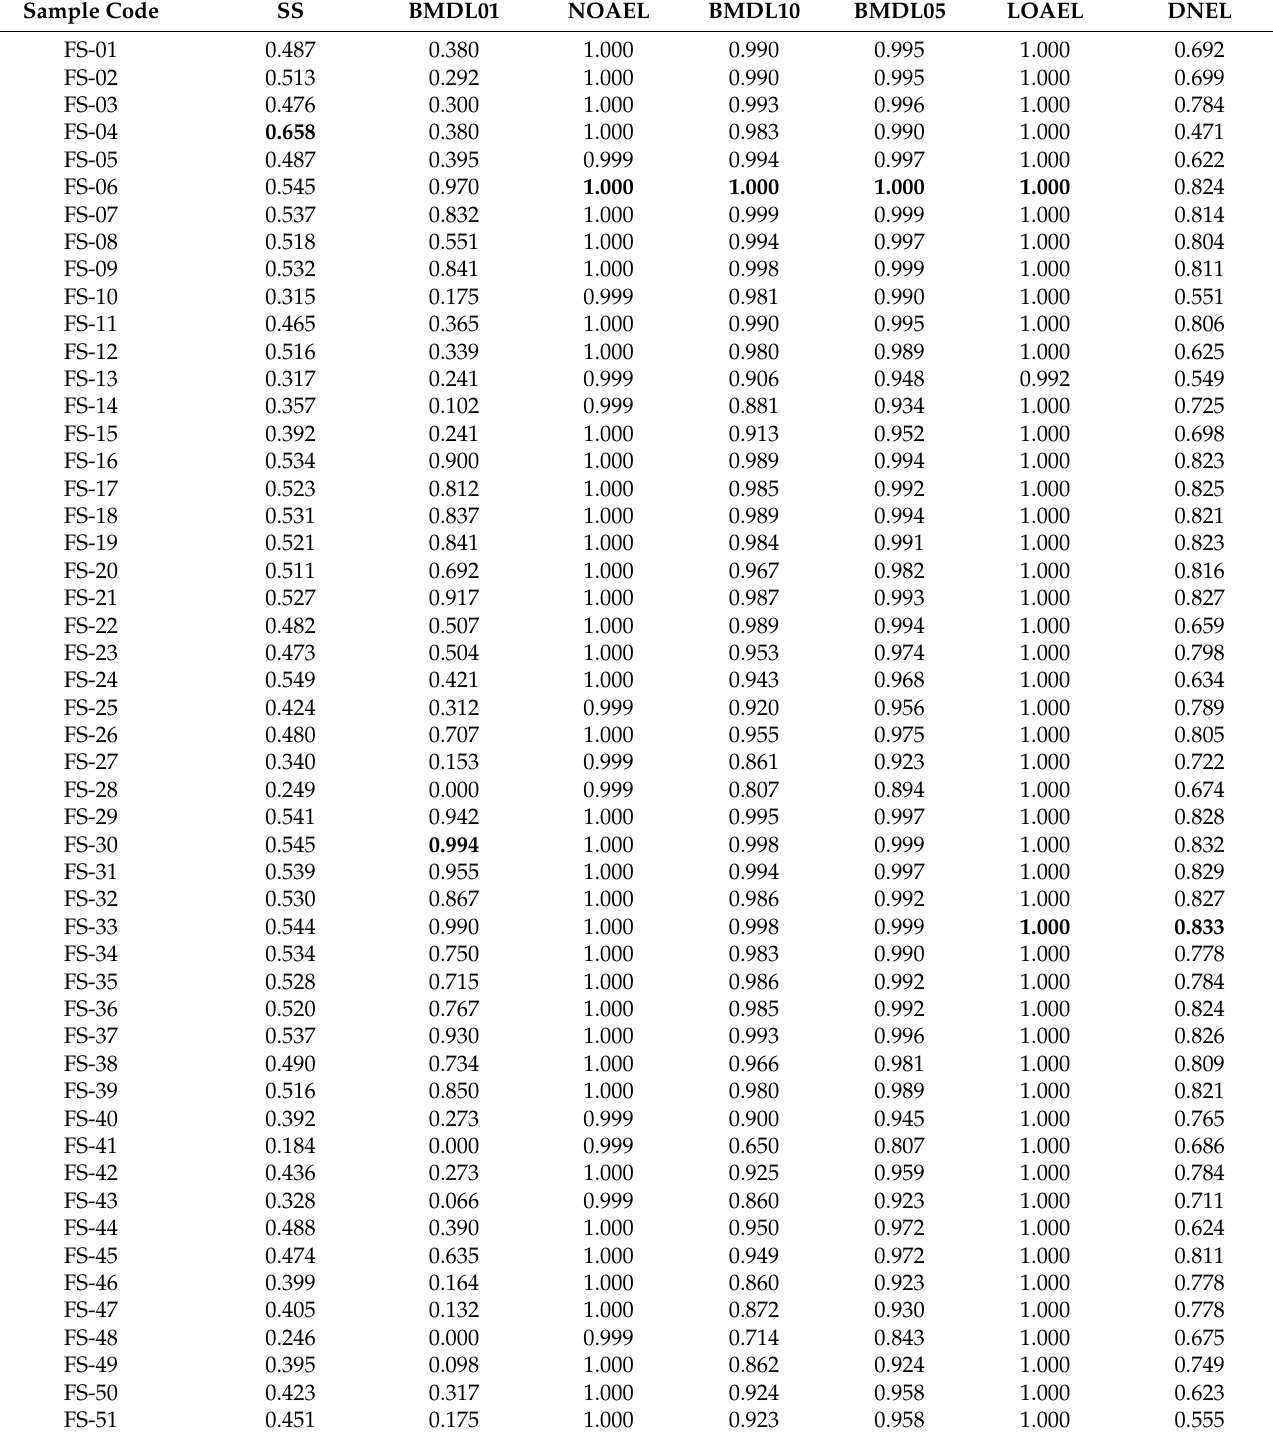
Table 6. Ranking of the observed